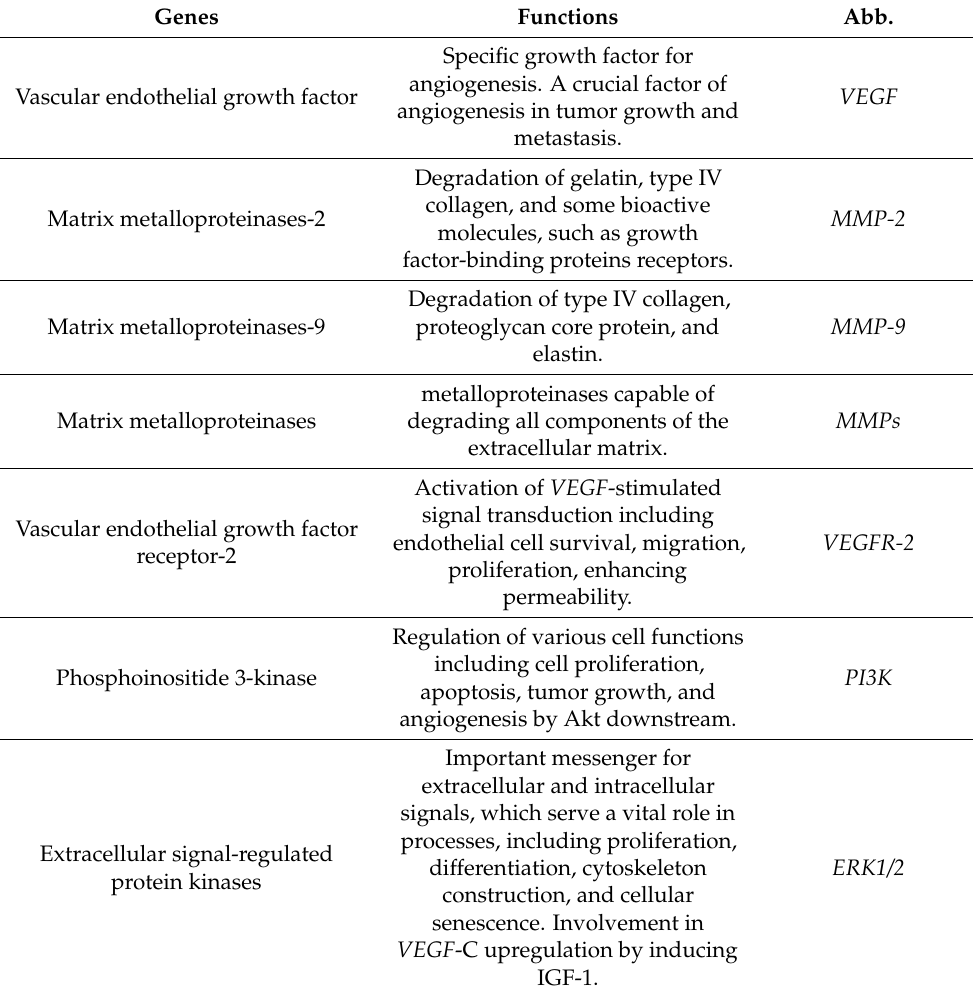
Table 2. Comparison of major gene expressions related to cell migration, proliferation, and enhancing vascular permeability. List of the abbreviations and functions of main genes comparing expressions in this experiment.